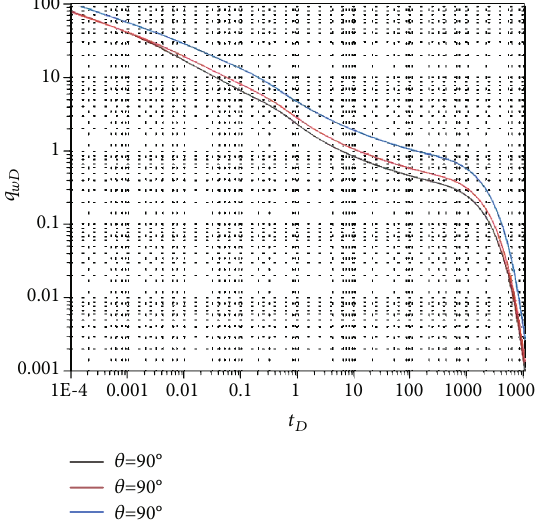
Figure 9: In fl uence of the included angle between the fracture and the x -axis on